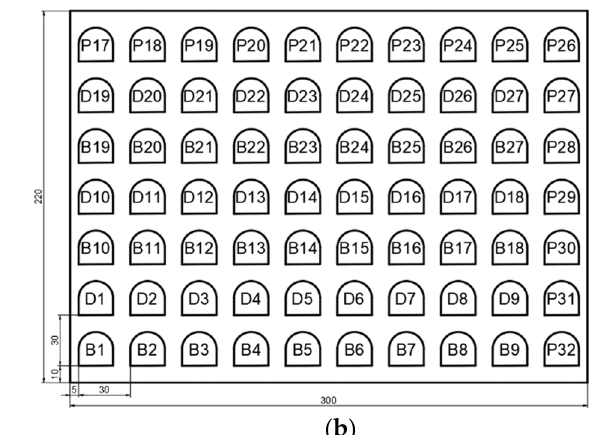
Gas pressure in the piercing phase (bar)